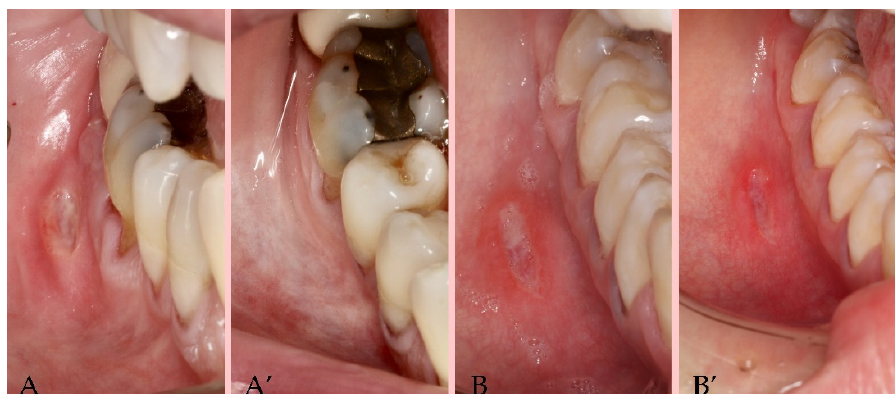
Figure 5. Effect of photobiomodulation ( A , A’ ) and placebo ( B , B’ ) treatment on aphtha’s healing. ( A – B ), the aphtha before treatments. ( A’ – B’ ), recovery at 8 days after treatments. Photobiomodulation therapy induced complete healing at 8 days from the photobiomodulation treatment ( A’ ), while, in the meantime, the patient treated with the placebo kept an evident and inflamed aphtha ( B’ ).